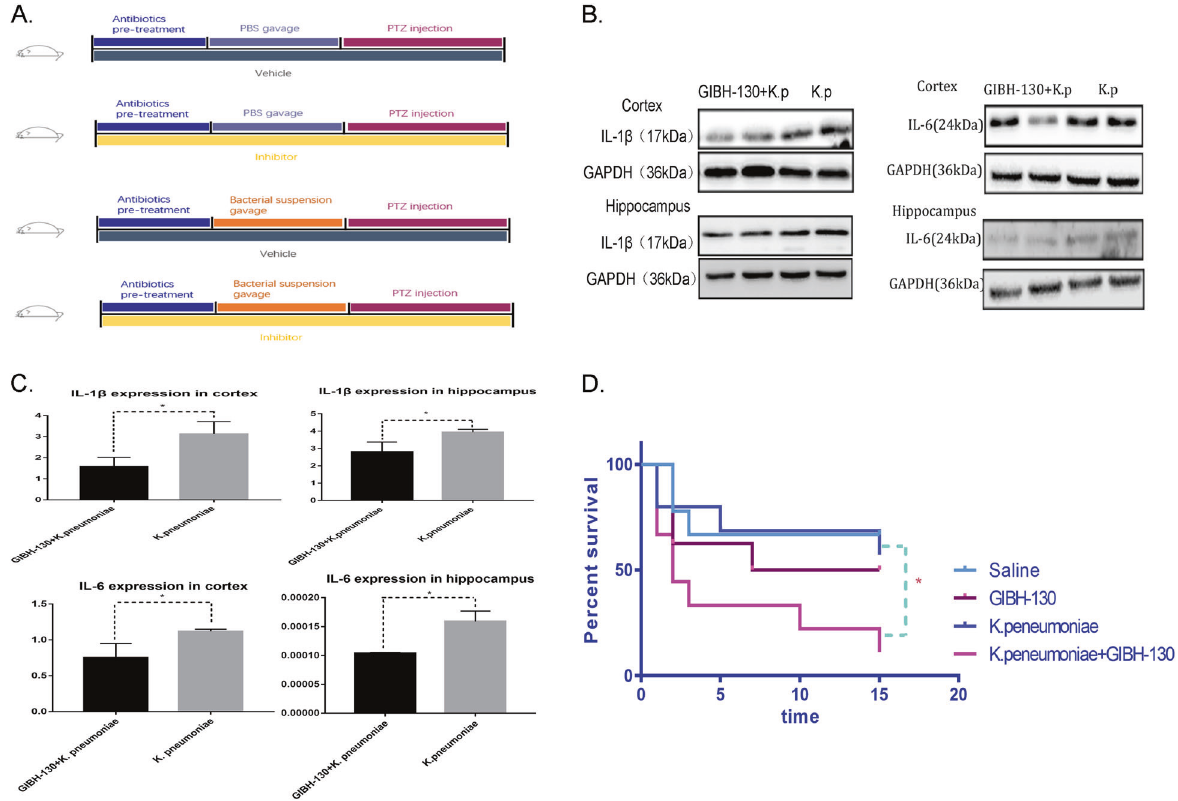
Fig. 5 Inhibiting the release of cytokines by activated microglial cells aggravates seizures. A Graphic representation of the intervention timeline in the animal experiment. B Representative images of IL-1 β and IL-6 expression in the cortex and hippocaumps of mice treated with K. pneumoniae and GIBH-130 + K. pneumoniae respectively. C Quanti fi cation of IL-1 β and IL-6 expression in the cortex and hippocaumps in two groups. Compared with that in the K. pneumoniae group, IL-1 β and IL-6 expression was decreased in the cortex and hippocaumps of mice in the GIBH-130 + K. pneumoniae group ( n = 3 in each group; * P < 0.05 versus controls, Student ’ s t test). D Percentage survival over the number of PTZ injections ( n = 8 in each group; * P < 0.05, log-rank